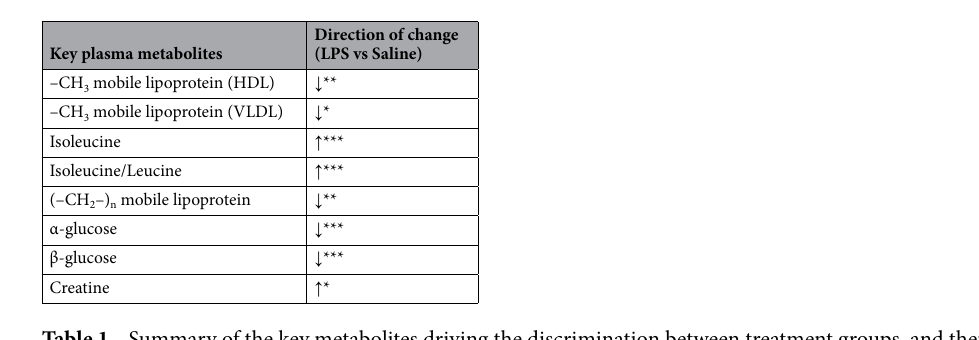
Table 1. Summary of the key metabolites driving the discrimination between treatment groups, and their direction of change compared to saline. HDL high density lipoprotein, VLDL very low density